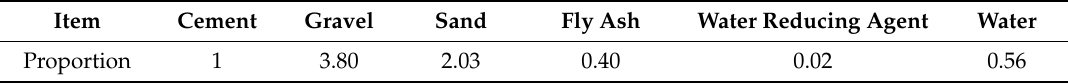
Table 1. Mixing proportions of concrete